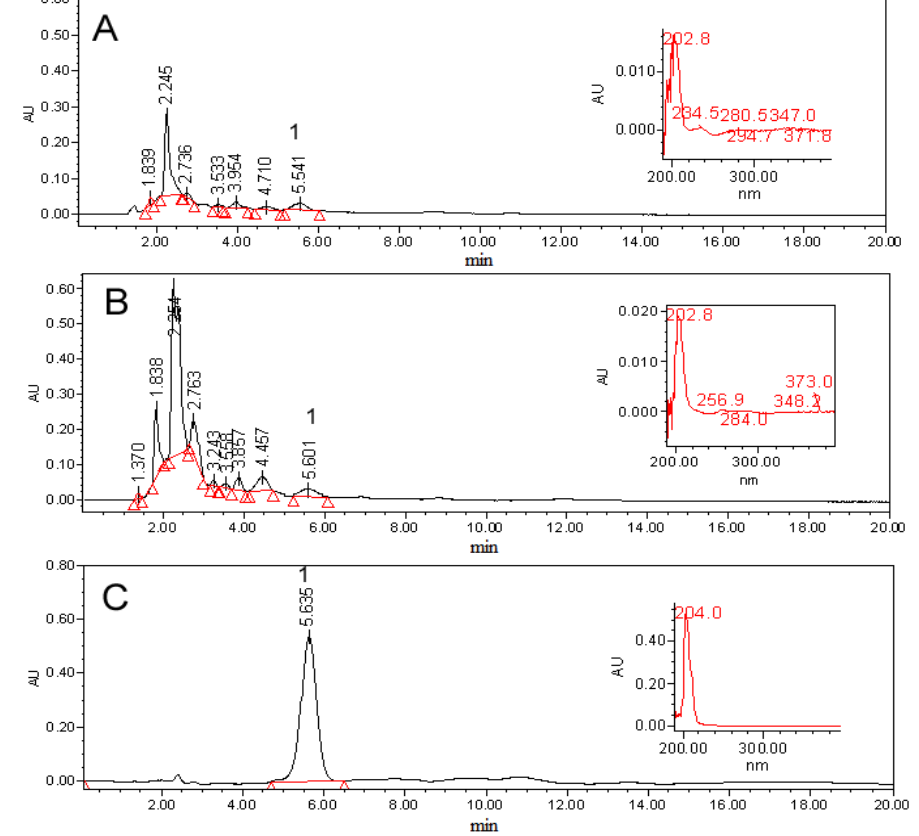
Figure 2. HPLC patterns showing the presence of compound 1 in: ( A ) Wild plant, and ( B ) In vitro culture seedlings, in comparison with ( C ) Compound 1 isolated from wild plant of L. racemosa